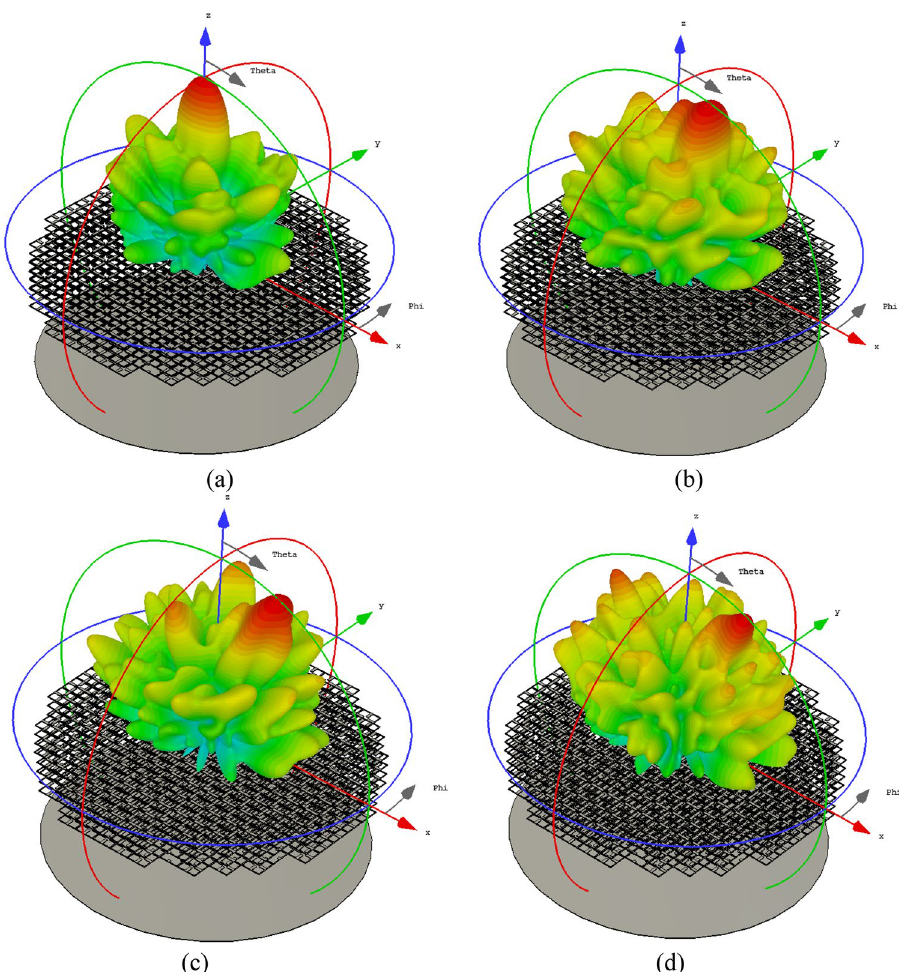
Figure 12. The bi-static RCS pattern for ( a ) θ i = 0 ◦ , ( b ) θ i = 10 ◦ , ( c ) θ i = 20 ◦ and ( d ) θ i = 30 ◦ .